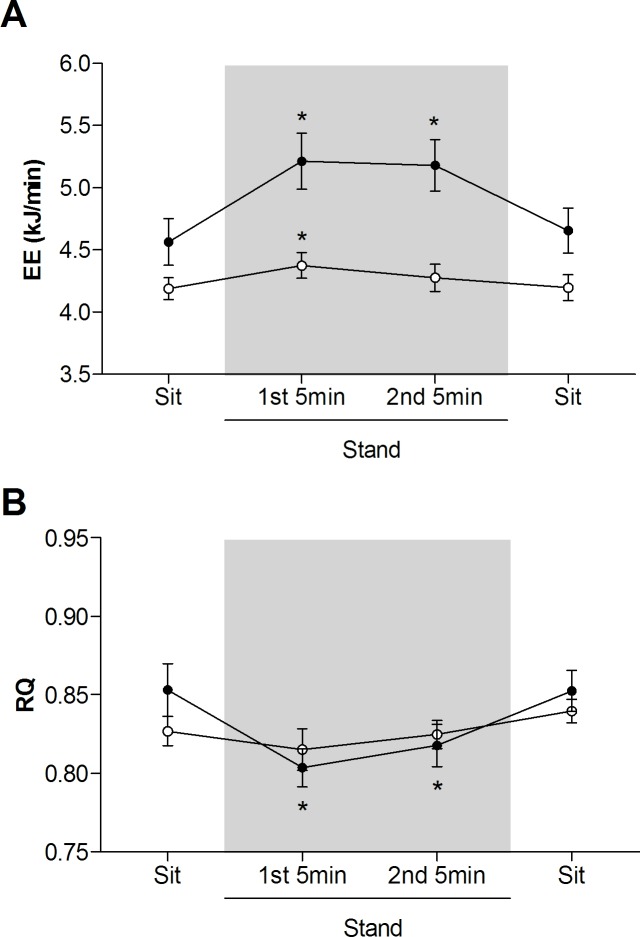
Energy expenditure (EE; Panel A) and respiratory quotient (RQ; Panel B) responses to standing compared to sitting (subjects grouped by EE response phenotype). Values mean ± SEM. Open circles represent energy savers; closed circles represent energy spenders. Shaded area indicates 10 min standing period. *statistically significant difference from first (baseline) sitting value.